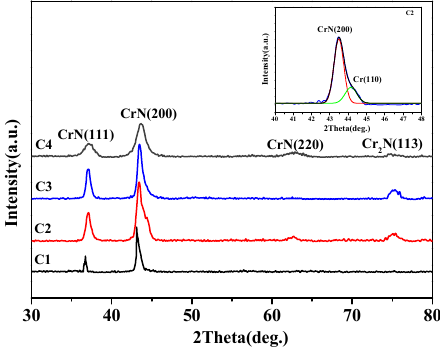
Figure 2. The XRD patterns of CrN films on 316L substrate. Table 2. The intensity ratio of (200) and (100) (I (200) /I (111) ) and average grain size of CrN films.